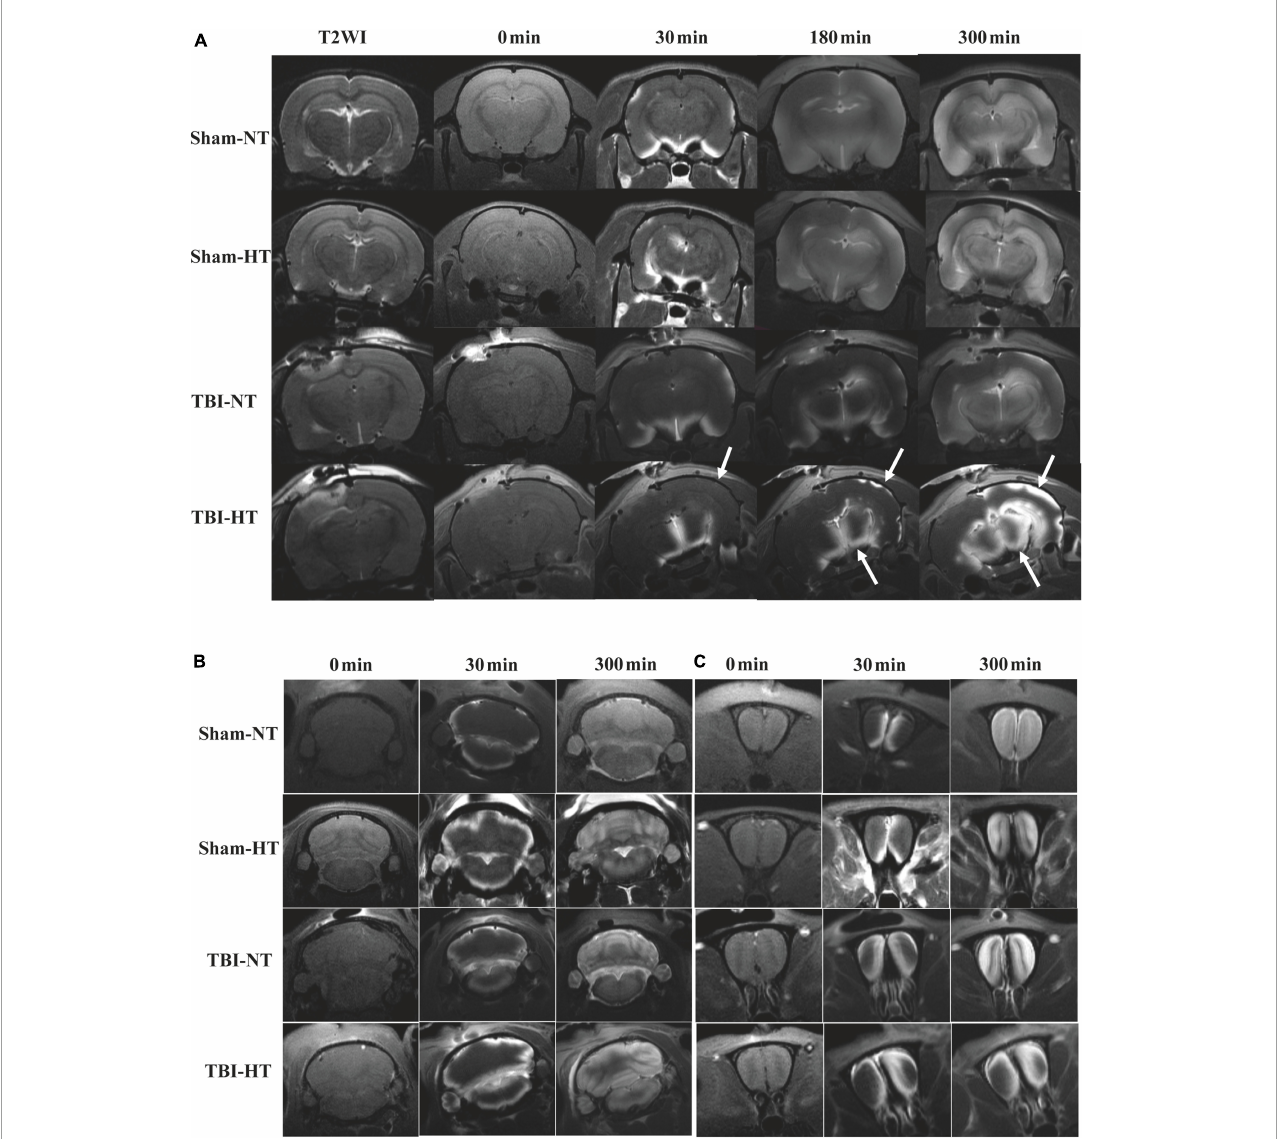
FIGURE4 Hypothermia induced dynamic contrast concentration changes in traumatic and sham injury brain after intrathecal infusion of small molecular weight contrast agent Magnevist. (A) The time series of coronal T1-weighted MRI images demonstrate early influx (0–30 min) and deep anatomic enhancement at 180 min and 5 h in subregions including the bilateral cortex, bilateral hippocampus, and bilateral thalamus in Sham-NT, Sham-HT, TBI-NT, and TBI-HT animal brains. Coronal T2WI is used as a reference to visualize brain subregions. As indicated by arrows, therapeutic hypothermia led to limited contrast agent diffusion into the cortex at 30 min, and it was restricted to the superficial cortex and partial thalamus at 180 min and incomplete whole-brain infusion at the end of the experiment (300 min) after Gd-DTPA infusion in the brains of TBI-HT rats. An asymmetrical hemispheric contrast distribution was detected in the injured brains of TBI-NT and TBI-HT rats. (B) The contrast distribution in the cerebellum demonstrates a symmetrical pattern with different infusion speeds. (C) An asymmetrical distribution pattern was detected in the olfactory bulb in TBI-NT and TBI-HT but not in sham injury controls during the same experimental